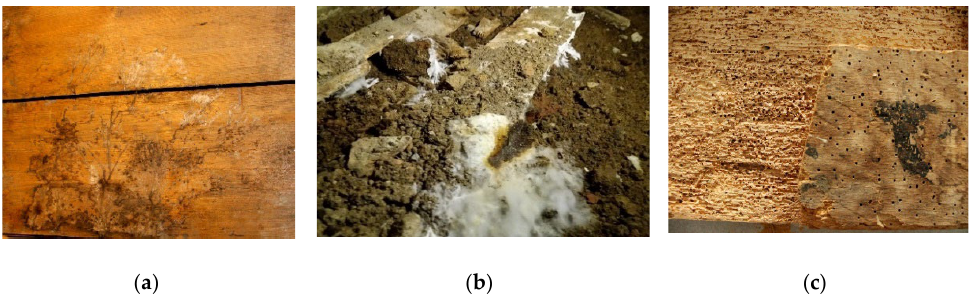
Figure 3. Wood degradation: ( a ) Coniophora puteana , ( b ) Serpula lacrymans and ( c ) Anobidae insects.